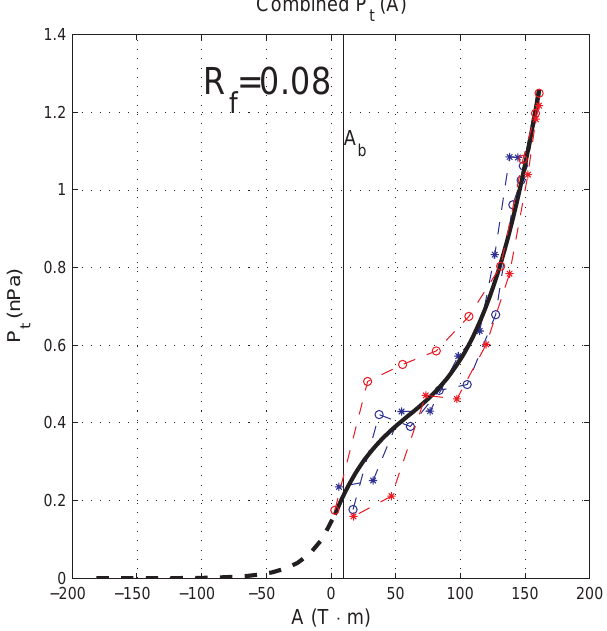
Fig. 10. Combined P t (A) plot (red ACE, blue WIND) with residue R f = 0 . 08. A third order polynomial is fitted (solid black) with an exponential tail (dashed black). Scattered points are the observa- tions – circles stand for the first half and stars for the second half of the event. The vertical line drawn at a value A b = 10Tm corre- sponds to the white contour line in Fig. 11.